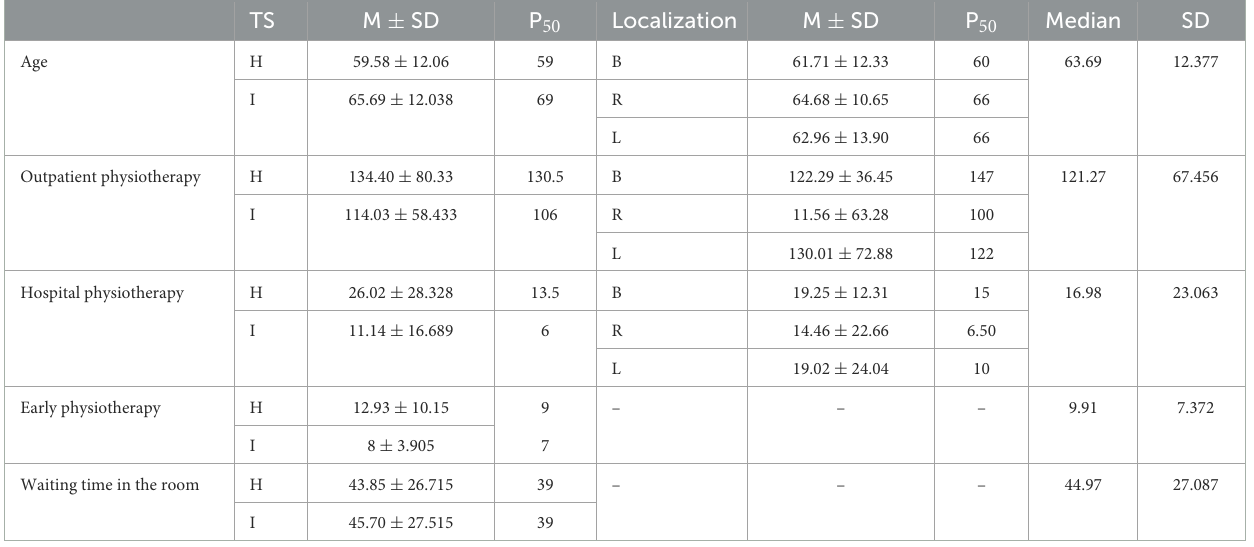
TABLE 1 Variables “stroke type” and “localization”: Student’s t -test and weighted